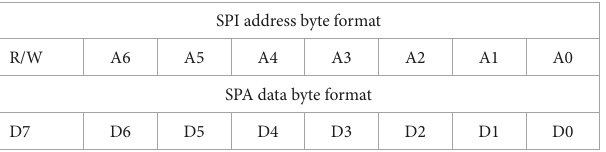
TABLE 1 SPI transfer